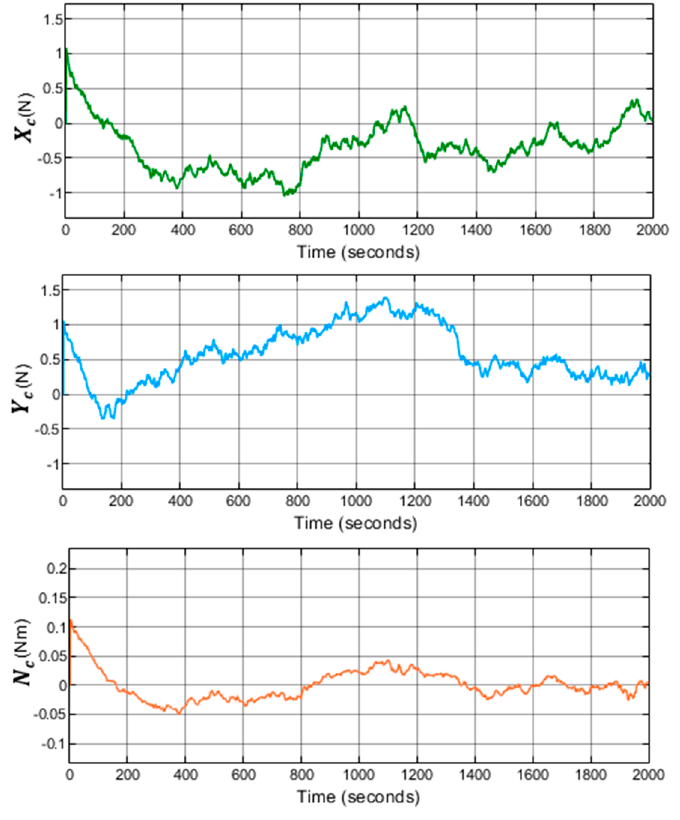
Figure 7. ( a ) System with LQG controller control results with waves, position x. ( b ) System with LQG controller control results with waves, position y and ψ .